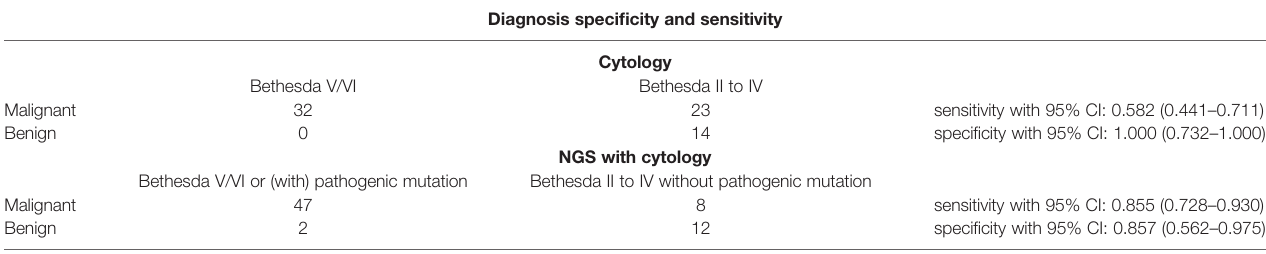
TABLE 3 | Diagnostic ef fi ciency of cytology and cytology combined with NGS.